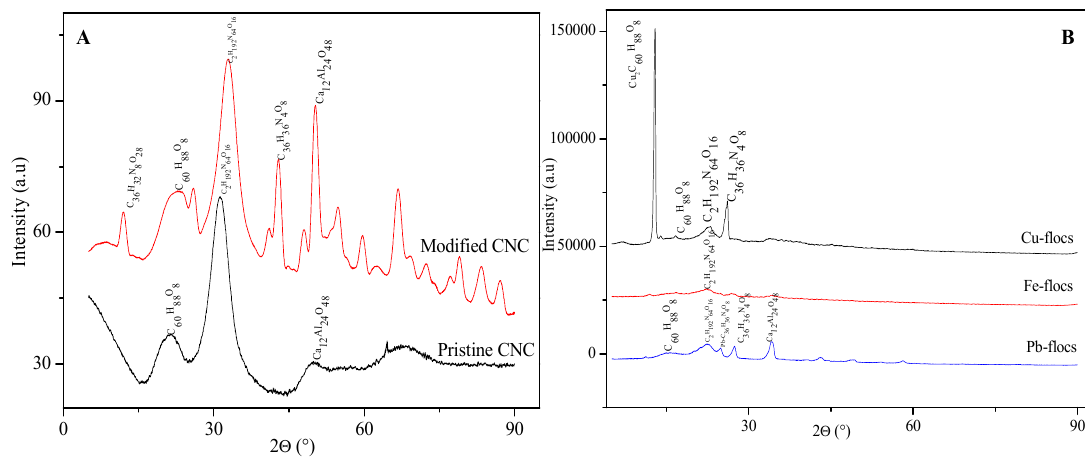
Figure 4. X-ray diffraction patterns of pristine CNC, MCNC and metal floccules.